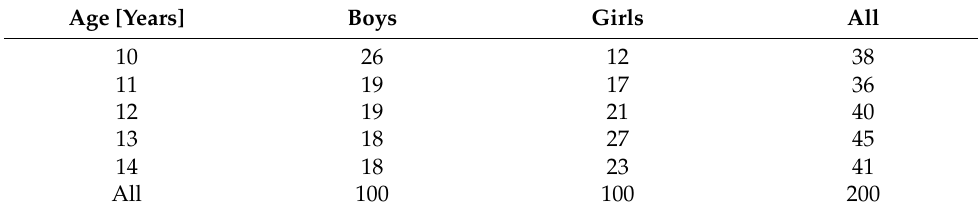
Table 1. The number of girls and boys broken down into age